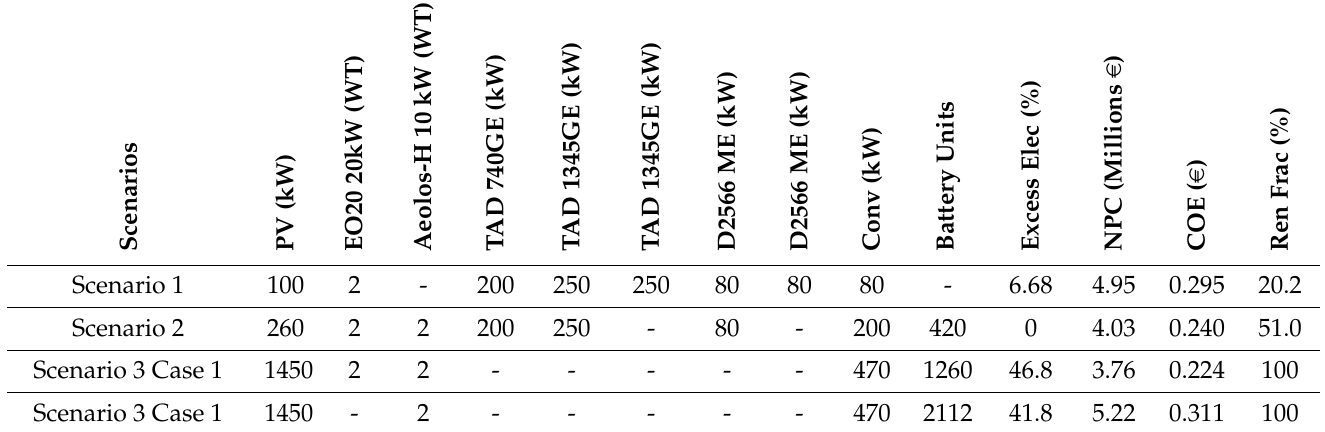
Table 33. Optimal systems configurations of the 3